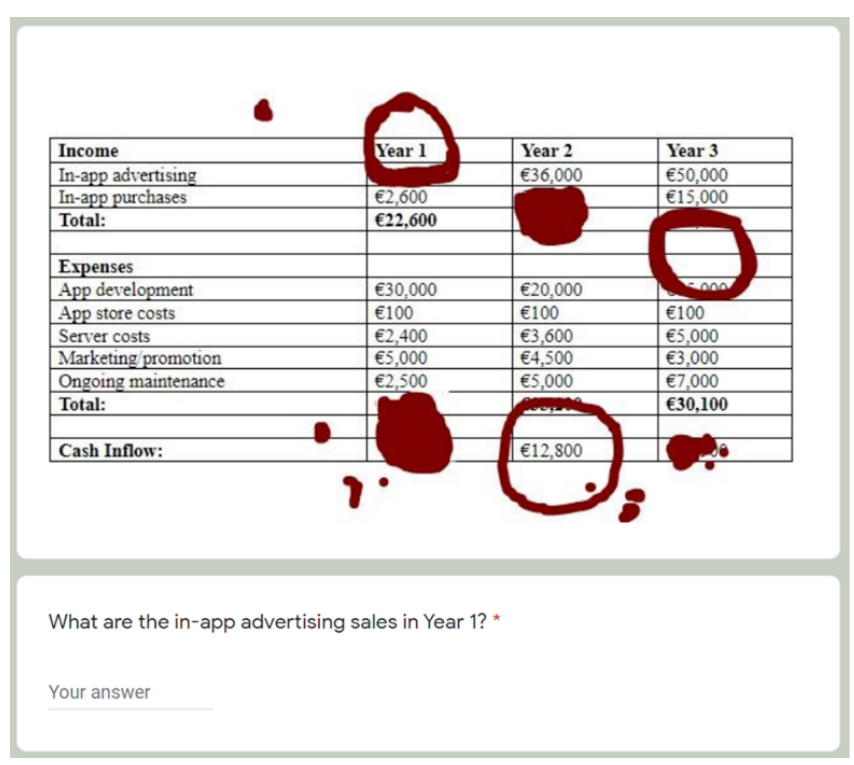
Figure 3. Example Clue from the “LIFE” Escape